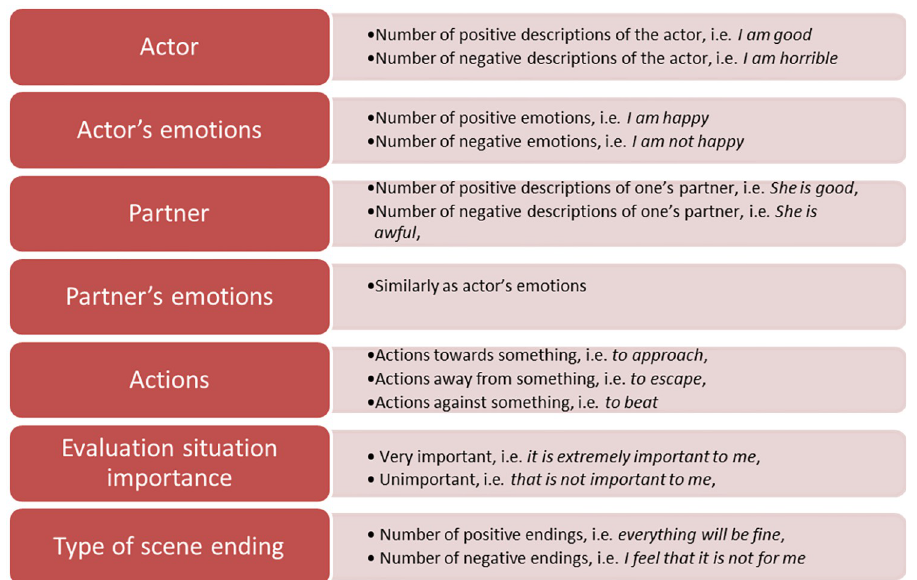
Fig 1. The components (and their indicators) of the scripts’